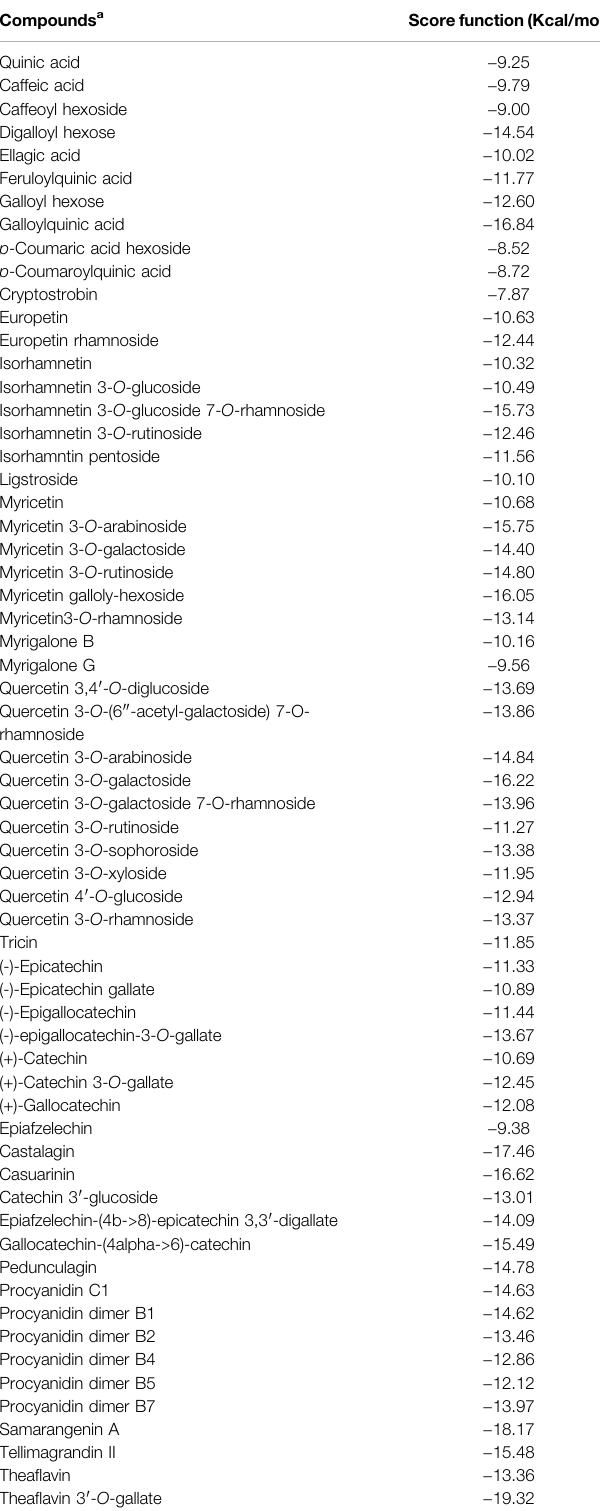
TABLE 1 | Docking scores of S. aqueum compounds into the active site of TLR4 using in silico molecular docking experiments. Compounds